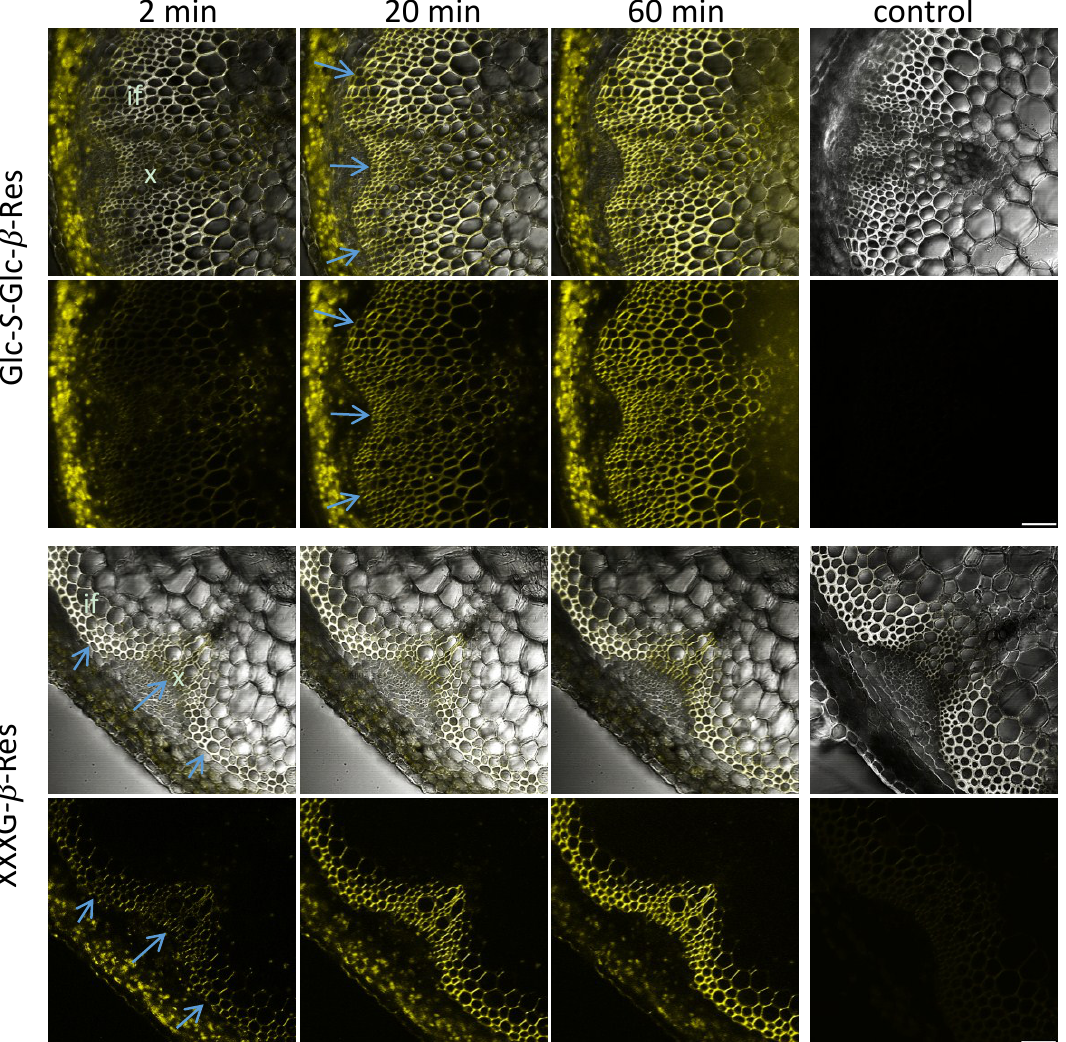
Figure 3. Distribution of signals in the inflorescence stem sections of Arabidopsis from Glc- S -Glc-β-Res and XXXG-β-Res substrates after incubations for the specified durations. The controls were boiled for 30 min before incubation for 60 min. Upper rows represent the transmitted light channel and the superimposed yellow fluorescence channel corresponding to resorufin signals, and the lower rows represent the yellow channel only. Blue arrows